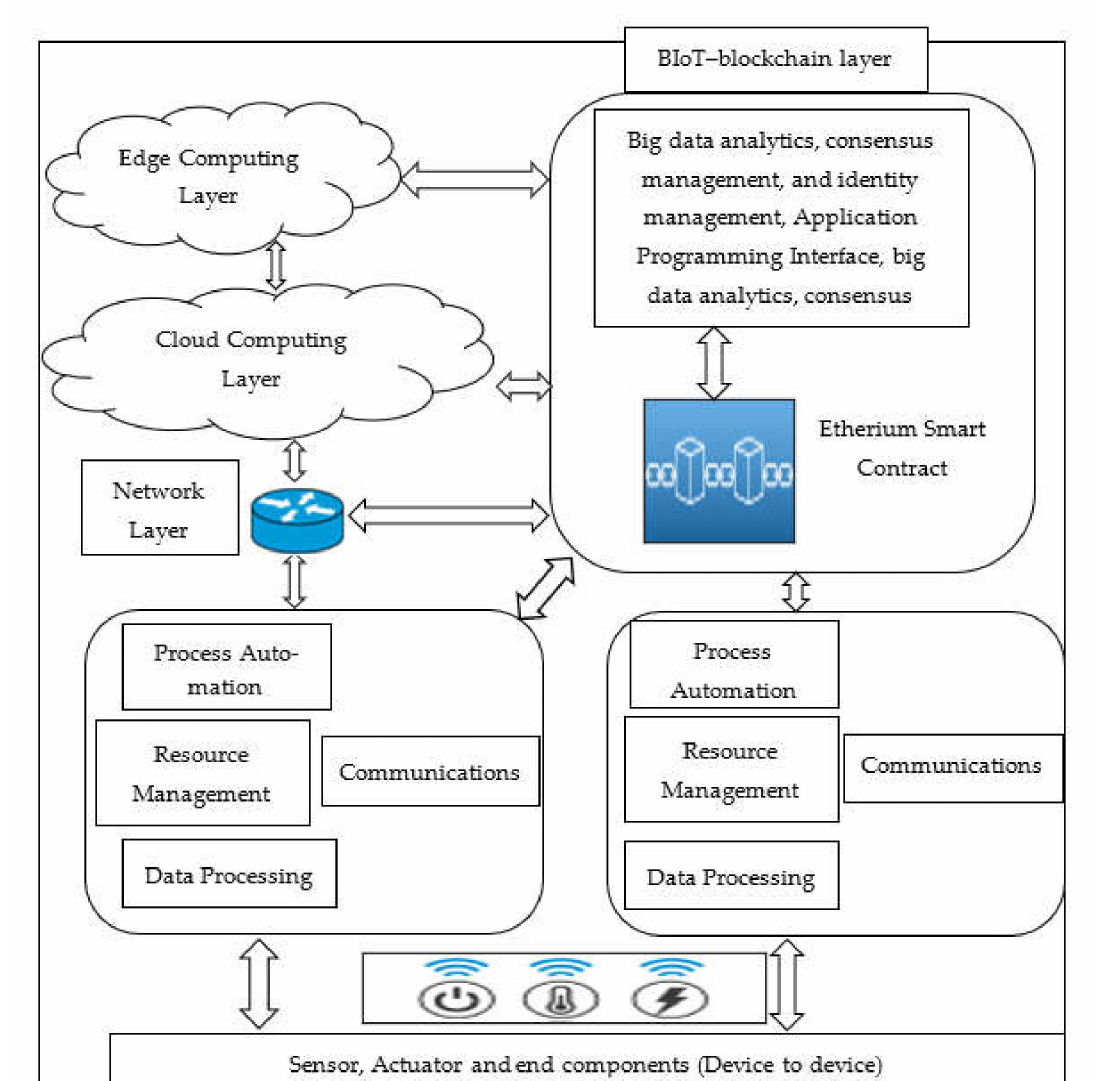
Figure 2. Device-to- Device BIoT